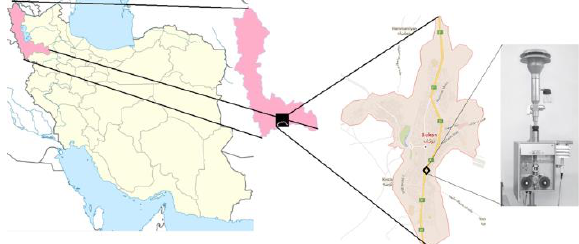
Fig.1 Location of the study area in Bukan city, West Azerbaijan, Iran.